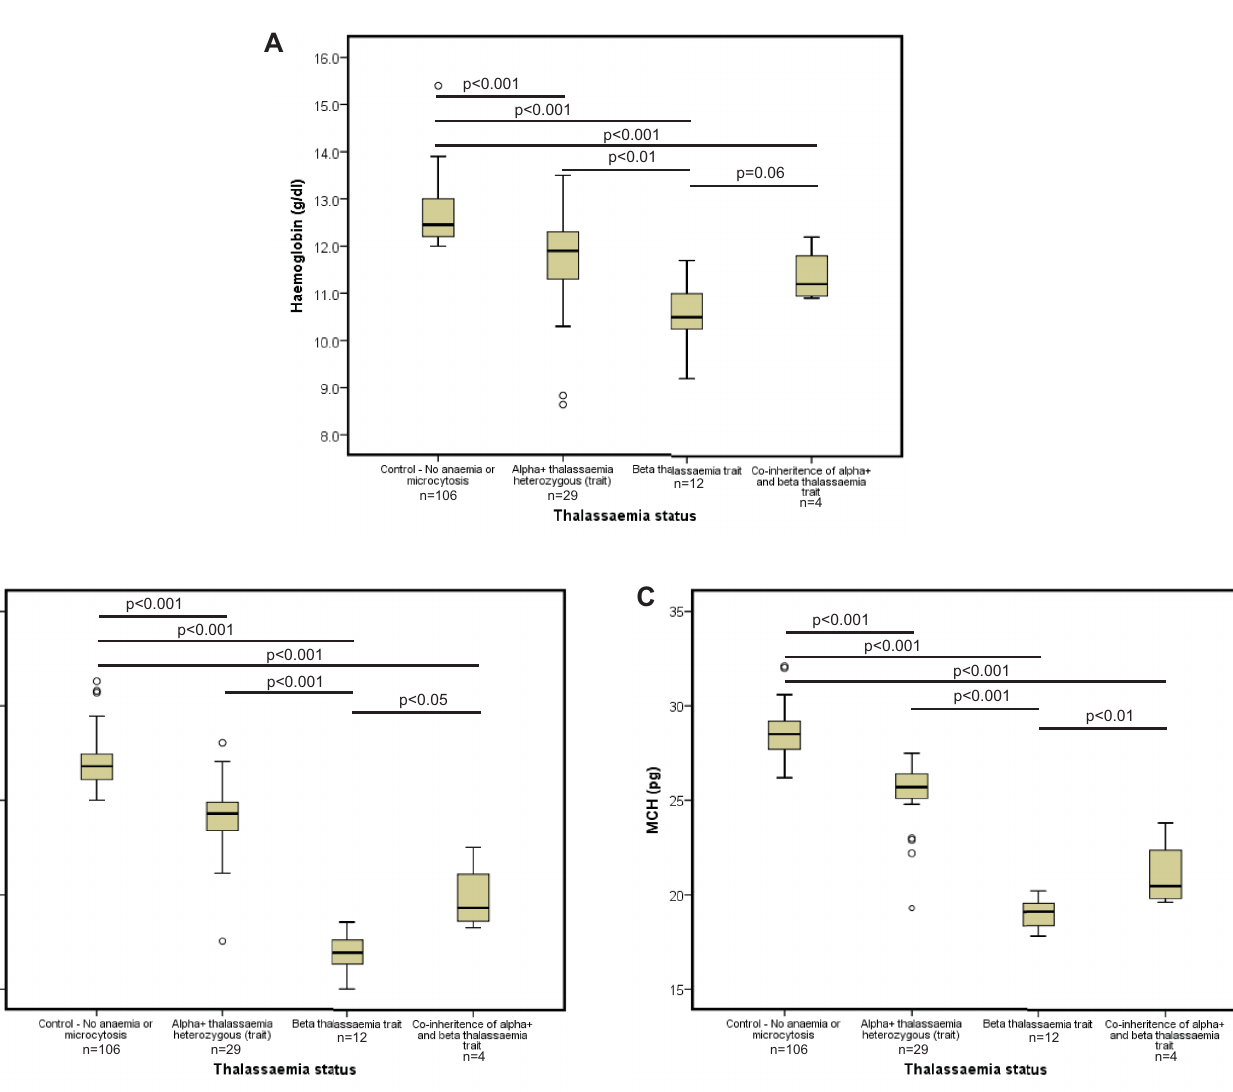
Fig 3. Distribution of (A) haemoglobin level, (B) MCV and (C) MCH in different heterozygous thalassaemia states. Each box plot shows interquartile range, middle horizontal bar shows respective median and error bars show range; outliers are marked in